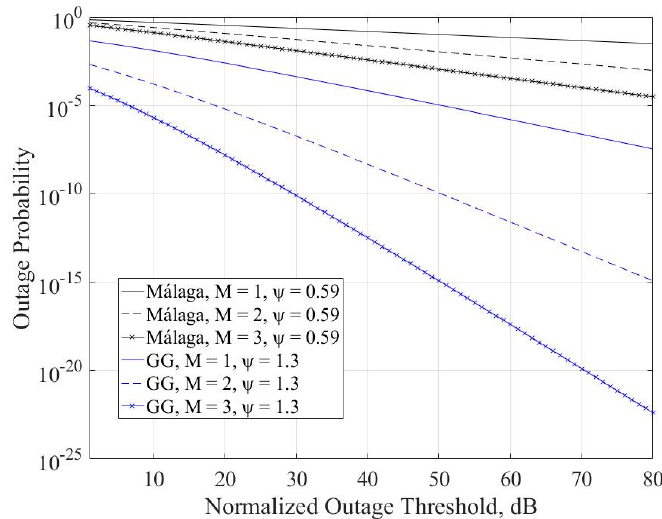
Figure 1. OP performance versus the normalized outage threshold for GG and Málaga cases.